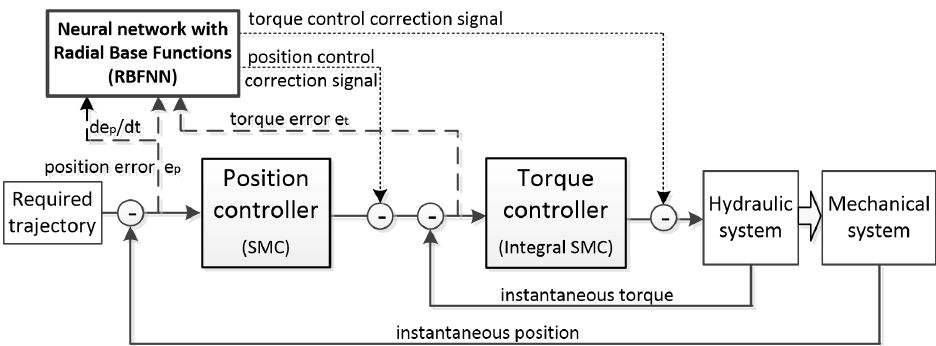
Figure 9. Control strategy of an electro-hydraulic elastic manipulator with the use of RBFNN by [30]. Table 3. Parameters of neural networks designed for neural control.